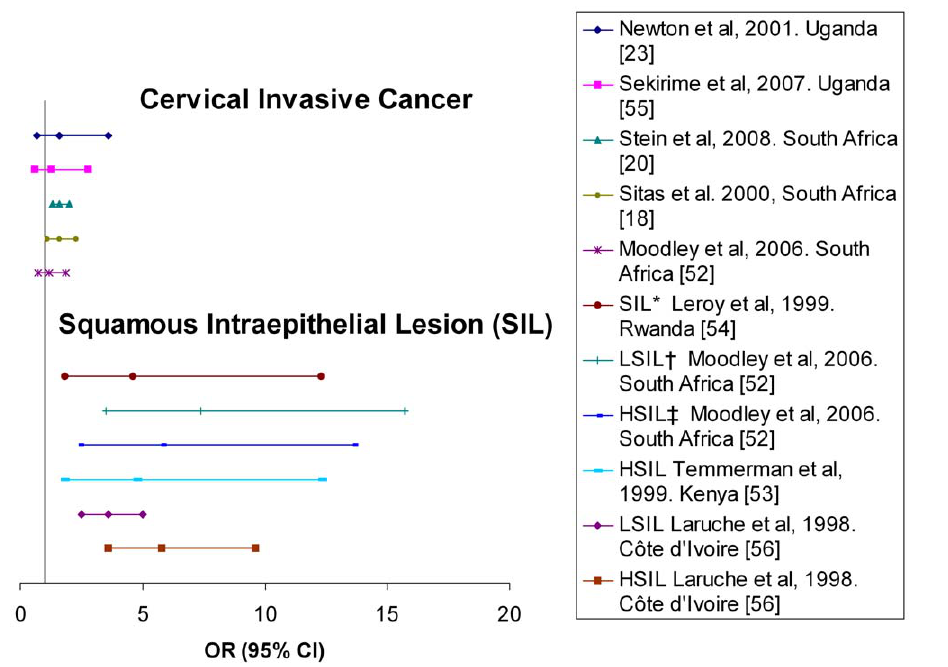
Figure 3. Odds Ratio (OR) and corresponding 95% confidence interval (95% CI) for the association between cervical abnormalities, invasive cervical cancer and HIV in sub-Saharan Africa. * squamous intraepithelial lesions { low-grade SIL { high-grade SIL.